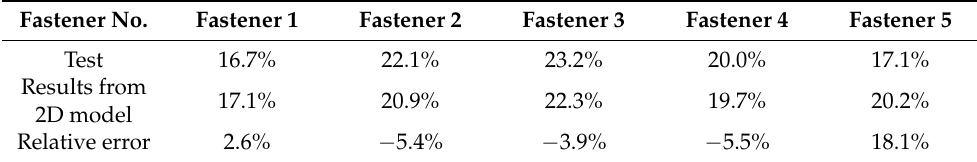
Table 3. Pin-load distribution ratio in the five-bolt joint.